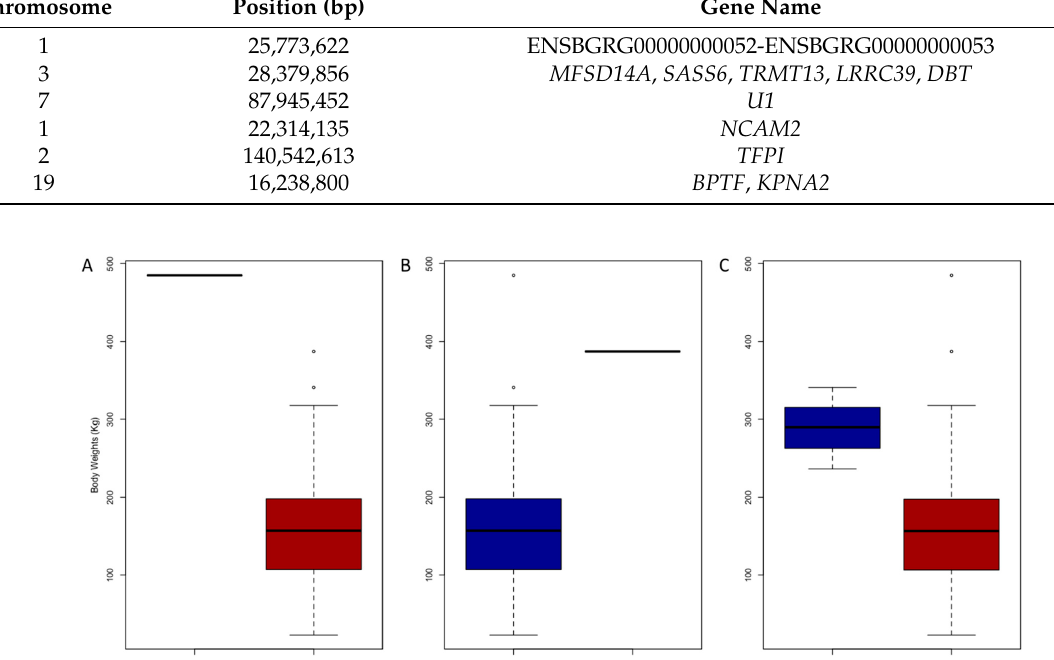
Figure 4. Phenotype distribution among the genotypes of the associated SNPs. The population was divided with the genotype of associated SNPs containing rs13559 ( A ), rs137207 ( B ), and rs371363 ( C ). In the figure there is only one individual with AA or GG genotype for SNP rs13559 or rs137207. For these three associated SNPs, there are no heterozygous genotypes observed in all individuals. Table 1. The candidate genes’ information of associated significant SNPs in the 200 kb region. The SNP No. indicates order number in the whole marker list. The chromosome and position mean the physical location information in the genome data. The gene names were annotated from GTF file in the BosGru_v3.0 reference genome. The values in the brackets are distance of base pair between